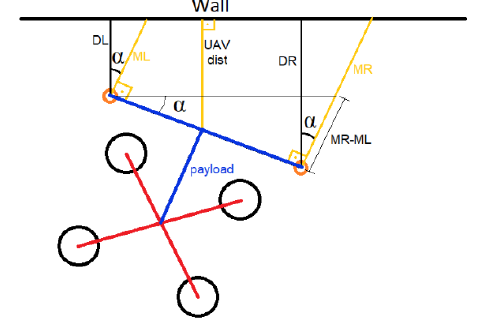
Figure 6. Trigonometric relationship between the measured distances and the UAV pose relative to the